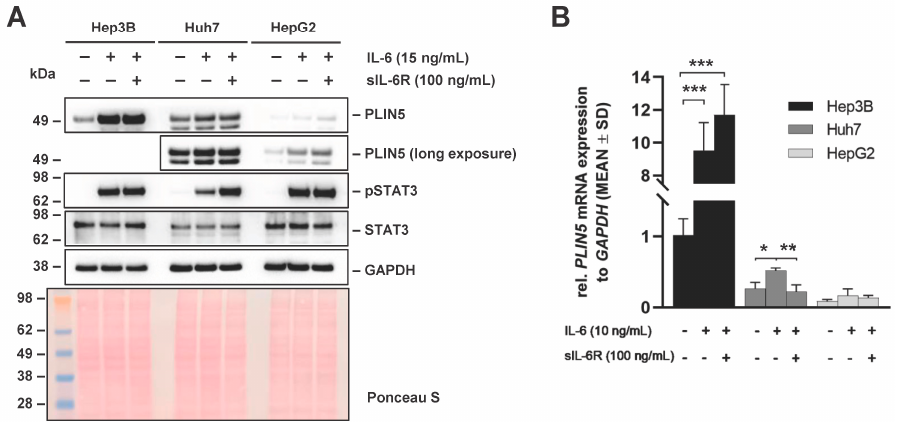
Figure 9. Effects on PLIN5 expression after simultaneous stimulation with IL-6 stimulation and sIL-6R in liver cancer cell lines. ( A ) Representative Western blot and ( B ) RT-qPCR results demonstrating the induction of PLIN5 protein and relative mRNA expression after IL-6 (15 ng/mL) stimulation alone or in combination with sIL-6R (100 ng/mL) for 24 h. GAPDH detection and Ponceau S staining served as controls to demonstrate equal protein loading. For RT-qPCR results, data are shown as mean ± SD of three independent experiments performed in triplicate and measured in technical replicates. Differences between the groups reaching significance are marked by asterisks (* p < 0.05, ** p < 0.01, *** p < 0.001).